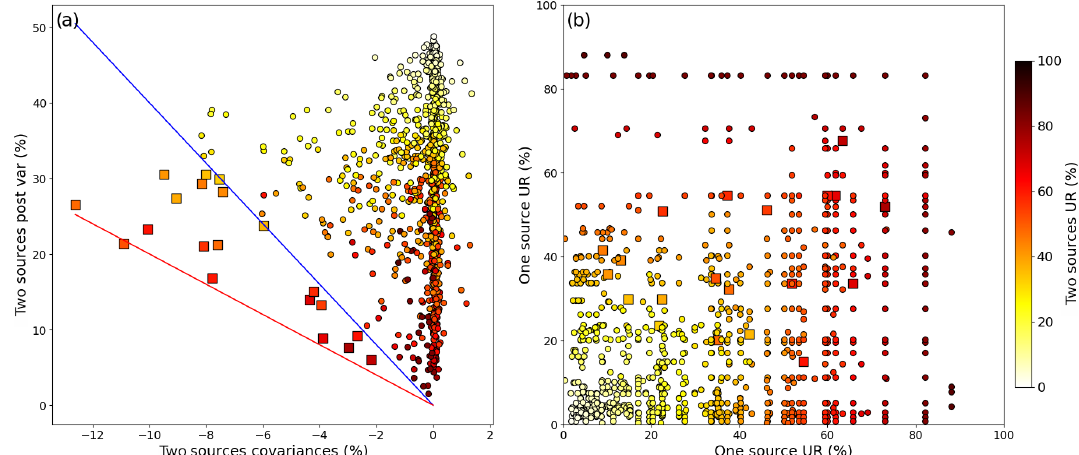
Figure 10. (a) Post-variances of the emission estimates for pairs of anthropogenic sources contained within a same region function of the covariances between the individual sources of the pairs. The colors of the markers correspond to the UR of the pairs. (b) Comparison of the URs for individual sources within each pair of anthropogenic sources contained within the same region: each symbol corresponds to a pair, with the UR for one of the two sources being given by the y axis and the UR for the other source being given by the x axis. The colors of the markers correspond to the UR of the pairs. The regions corresponding to this plot are contained within the 2km resolution area of the model. Results are derived with an instrumental resolution of 2km × 2km, a precision of 0.6ppm and a swath of 900km. Prior uncertainties on the 6h budgets of the point sources, urban and countryside areas are taken to be equal to 50%, and prior error correlations between hourly emissions have a temporal length of 3h. Pairs of anthropogenic sources are made up of point sources and of urban and countryside